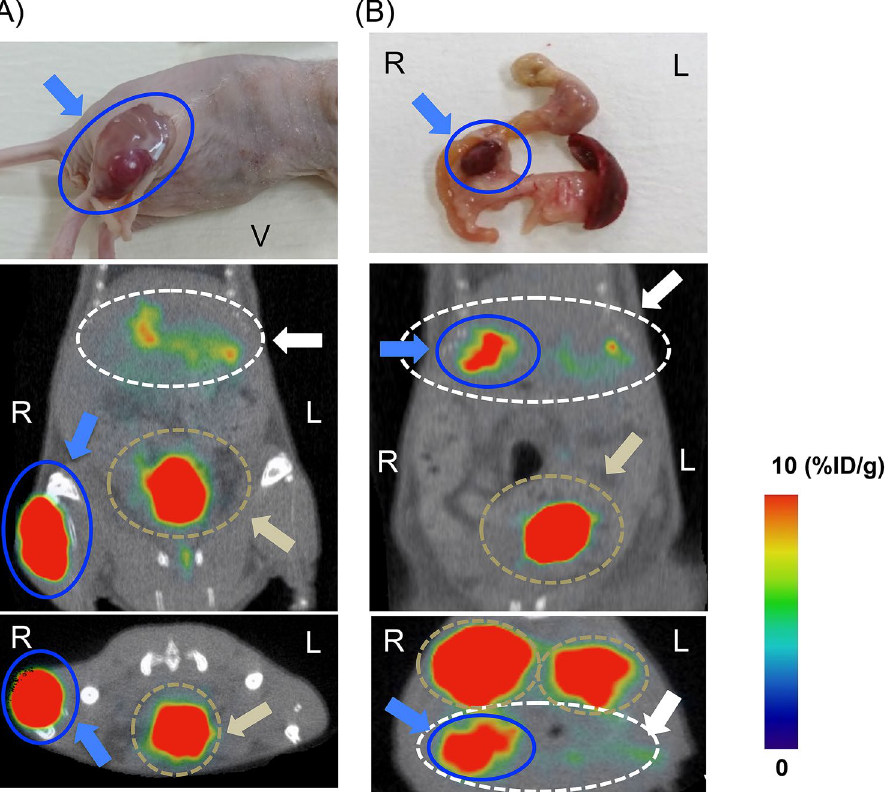
Figure 1. Representative [ 18 F]FB(ePEG12)12-exendin-4 PET/CT images in INS-1 xenograft mice. INS-1 tumors of the right thigh ( A ) and pancreas head ( B ) were visualized in INS-1 xenograft BALB/c slc- nu / nu mice on [ 18 F]FB(ePEG12)12-exendin-4 PET/CT images. In the upper panels, gross images of INS-1 tumors are shown (blue arrows and circles). Coronal and axial images are displayed in the middle and lower panels, respectively. Maximum to minimum intensity: red > orange > yellow > green > blue > black. The signals from the INS-1 tumors are blue arrows and circles. The signals from the pancreas are white arrows and dotted circles. The signals from the bladder are yellow–brown arrows and dotted circles. The signals from the kidney, yellow–brown arrows, and circles. %ID/g is the formula used in obtaining the uptake values of the region of interest per injected dose of the probe; L, left; R, right; V,